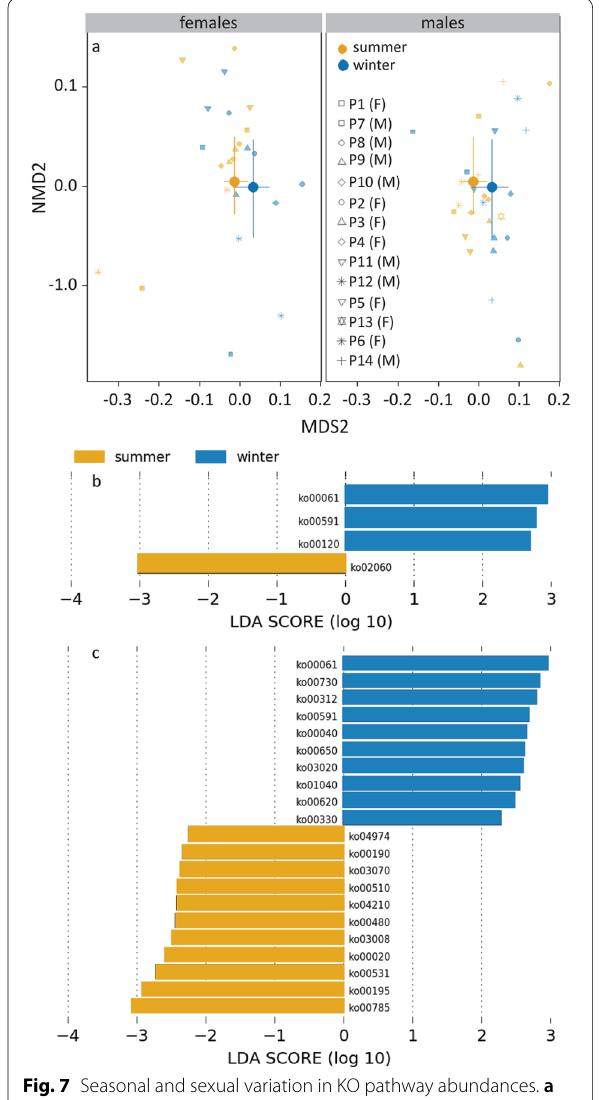
Fig. 7 Seasonal and sexual variation in KO pathway abundances. a MDS plot of seasonal differences within sex. b KO pathways that were more abundant in summer or winter in females. c KO pathways that were abundant in summer or winter in males. Statistics are presented in the text. The large symbols represent the medians, the error bars the 25% and 75% quantiles. The transparent symbols present the underlying data for the individual pigeons